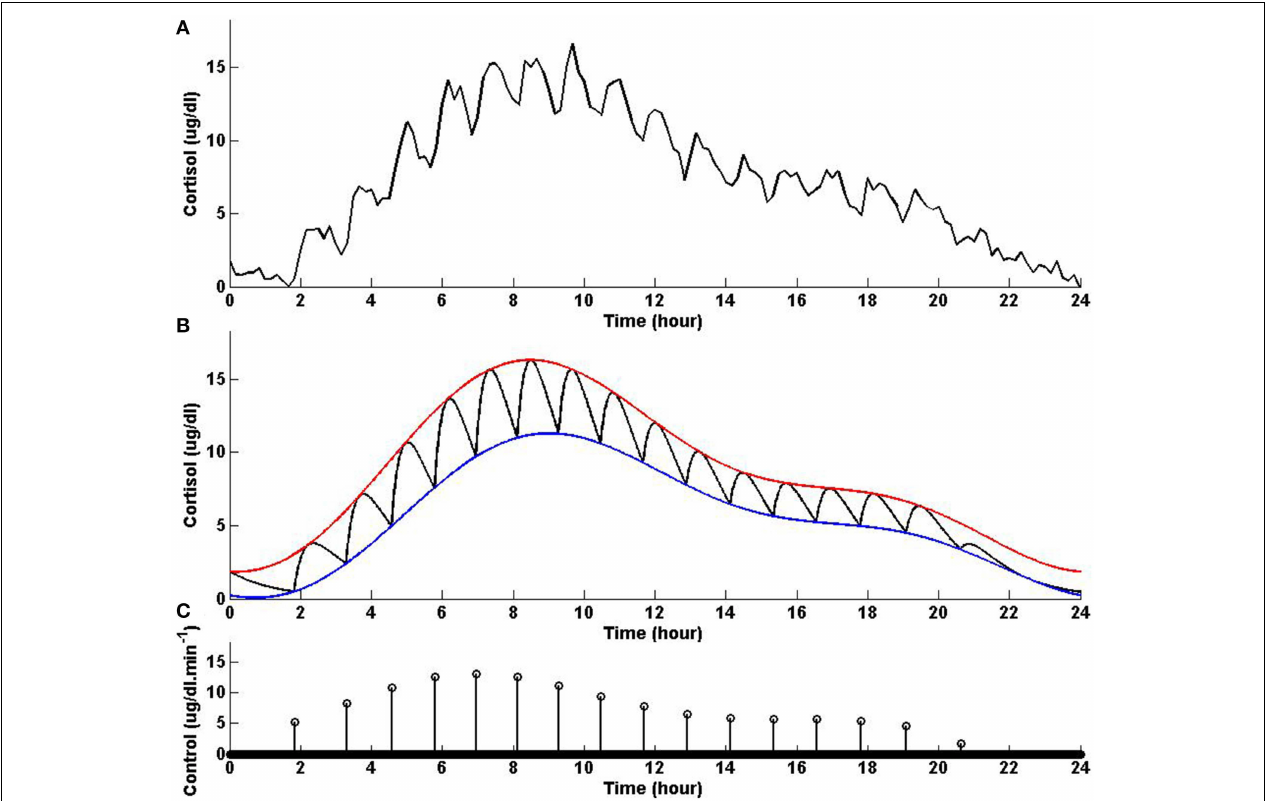
displays the obtained control. The optimization problem obtained 16 impulses over 24 h as the control (the timing of the control was discretized into 1440 points; the obtained control takes 16 non-zero values, i.e., impulses, while it is zero everywhere else). The optimization problem was solved using the parameters given in Example 3 in Table 1 and the upper and lower bounds provided in Tables 2 , 3 ,